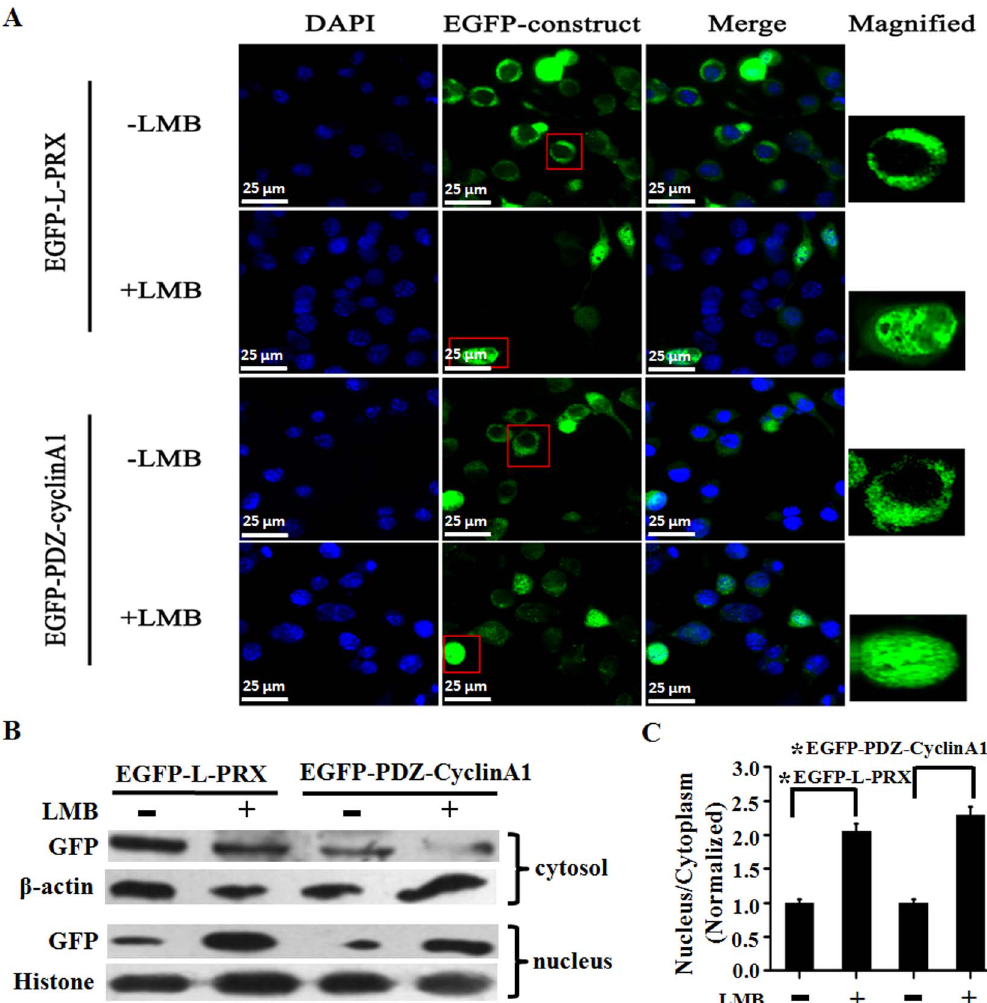
Figure 3. Nuclear export of L-periaxin is inhibited by LMB. (A) RSC96 cells were transfected with the plasmids encoding EGFP-tagged L-PRX and PDZ-cyclin A1. The cells in the second and fourth panels were treated with 37 nmol/L LMB for 1 h after 7 h post-transfection. EGFP-L-PRX and EGFP-PDZ-cyclin A1 localization was observed by Delta Vision. Scale bar=25 m m. (B) The cytosol and nucleus were separated and determined the distribution of protein in the two fractions by Western blotting. b -actin and Histone served as an internal control for cytosol and nucleus, respectively. (C) Quantitative analysis of the distribution of EGFP fusion proteins in the two fractions by normalized to the internal control level. *P , 0.05.